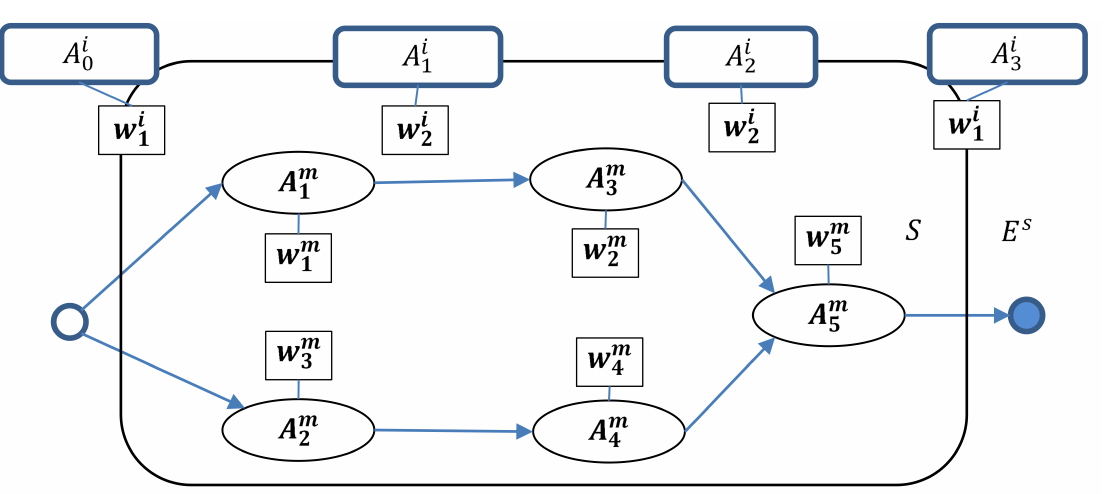
Figure 1. An example of the model of a complex technical system.